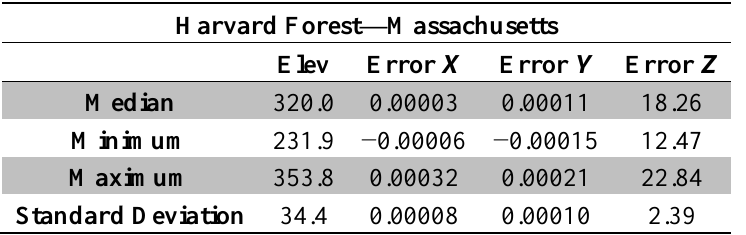
Table 3. Errors for sixteen GCPs used for each study region based on the difference between actual and model predicted GCP locations in